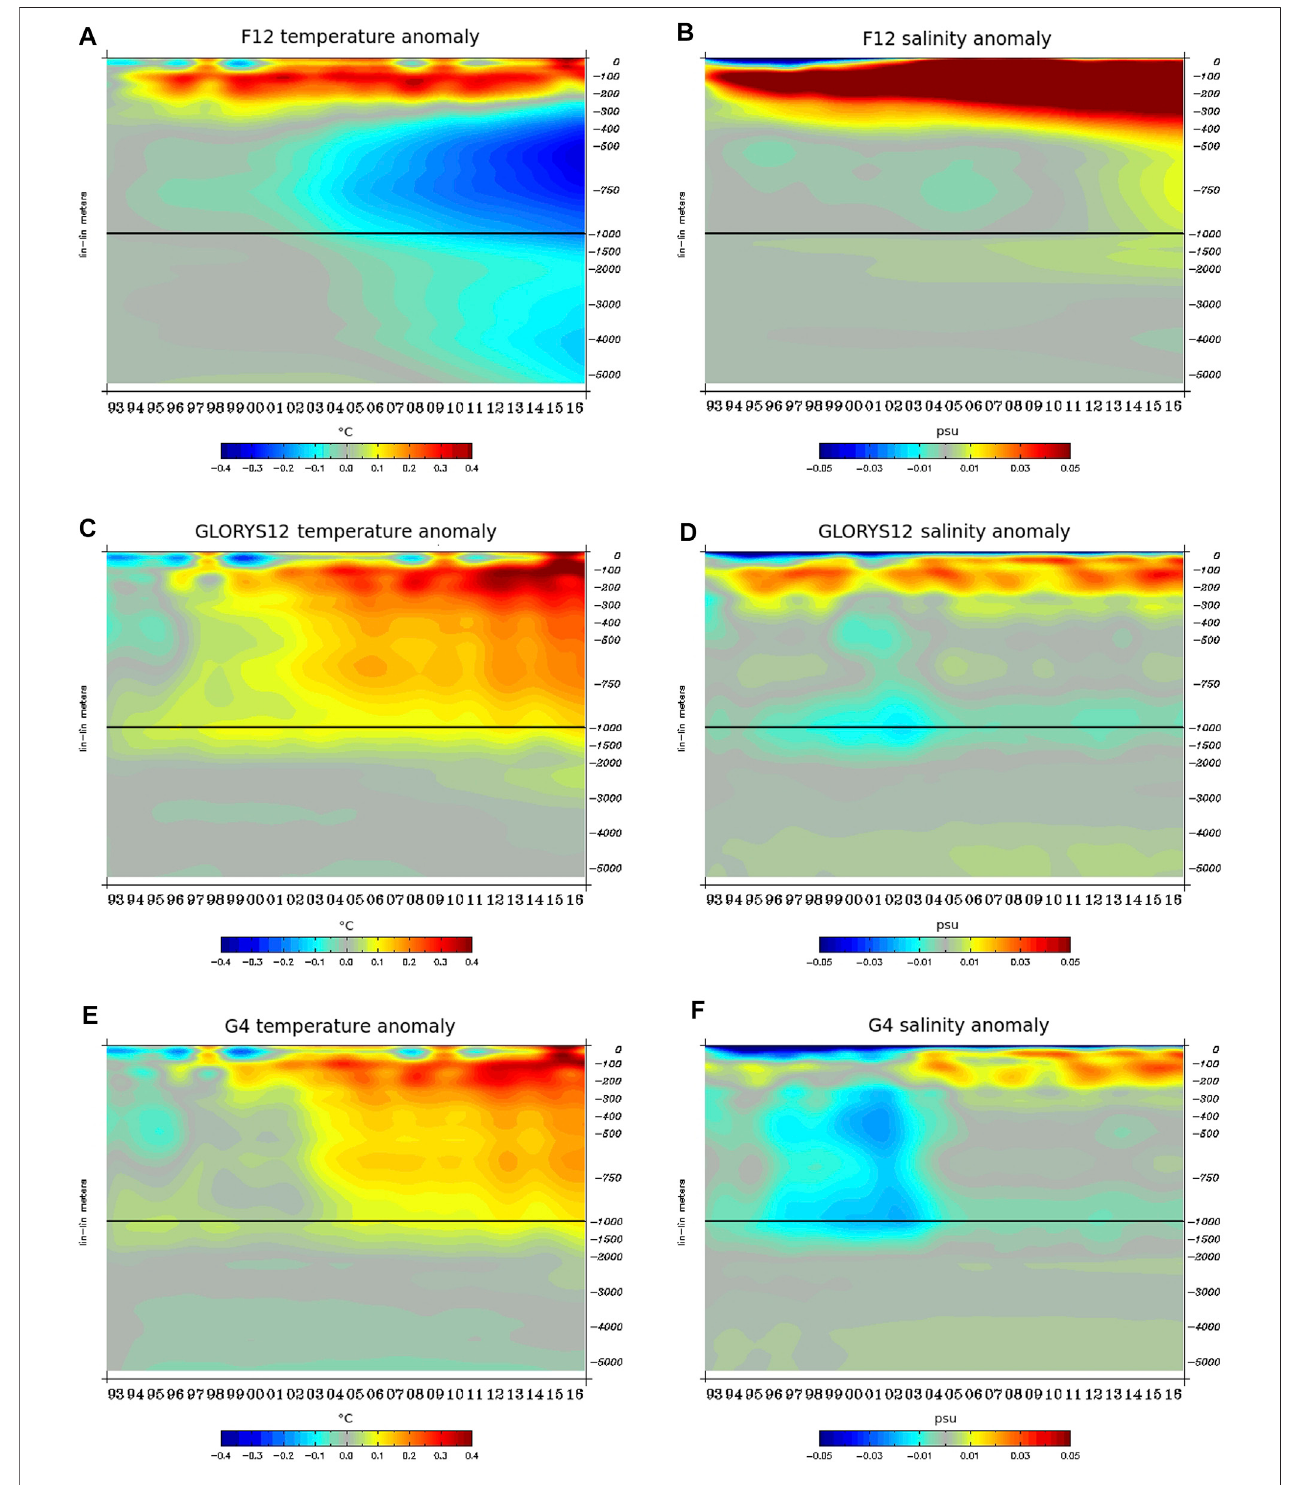
FIGURE 13 | Time evolution of temperature (in ° C, left panels) and salinity (in psu, right panels) anomalies over the whole domain for F12 (top panels A,B ), for GLORYS12 (middle panels C,D ) and for G4 (low panels E,F ). An Anomaly for a speci fi c date is de fi ned as the difference between the value at this current date and the value at the initial state. The interannual signal has been removed using a digital time fi lter.